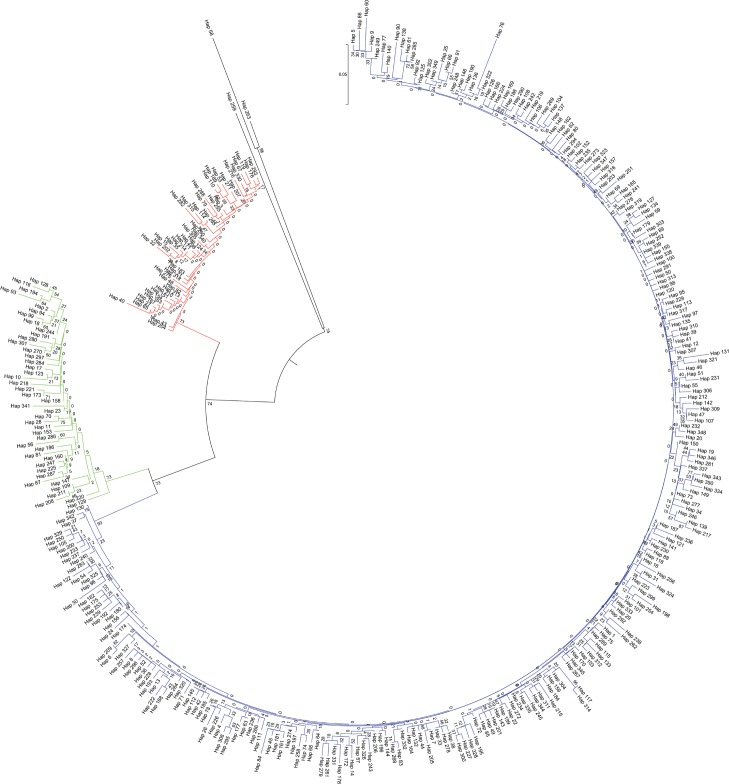
The ME phylogenetic tree of 350 haplotypes.The ME phylogenetic tree show that the 350 haplotypes and 636 sequences of Tibetan sheep populations and six reference breeds fall into five distinct clusters: haplogroup A, haplogroup B, haplogroup C, haplogroup D (Hap 259 of LZ 03) and haplogroup E (Omusimon and Ovignei), respectively. Haplogroups for individuals defined by the entire haplotypes are shaded in blue (haplogroup A), green (haplogroup B), and red (haplogroup C).